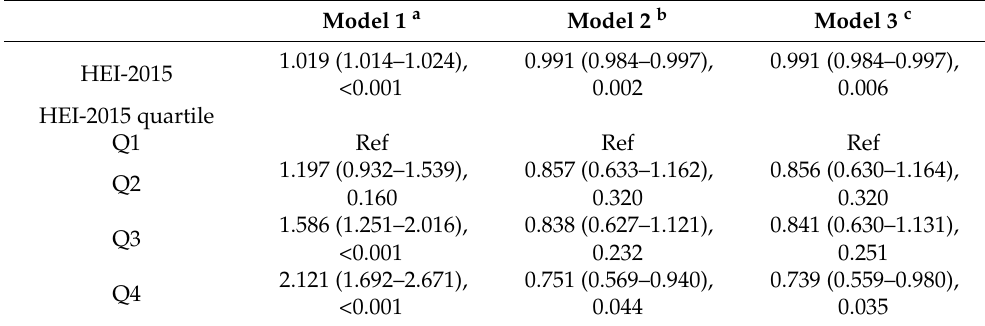
Table 2. Association of HEI-2015 with cataract.